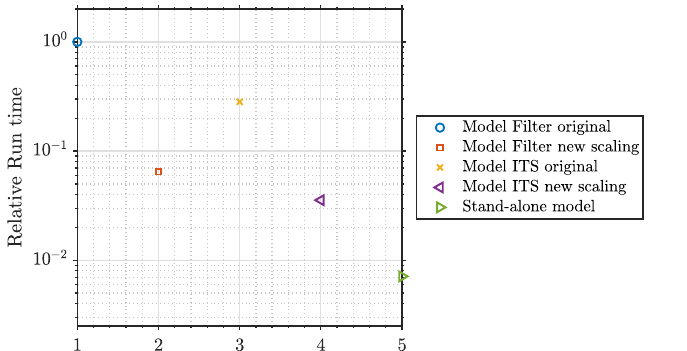
Figure 10. Relative computational time of the presented analytical models to estimate the wake velocity deficit at a downwind distance of 8 rotor